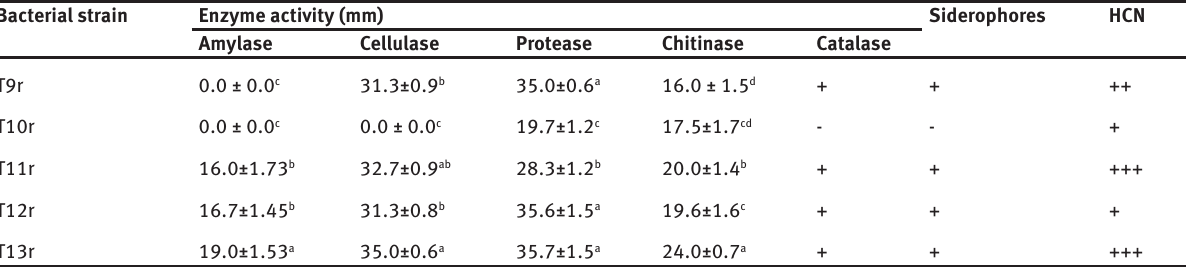
Table 4: Plant growth-promoting activities including enzyme activity, siderophores, and HCN production of the most potent selected endophytic bacterial